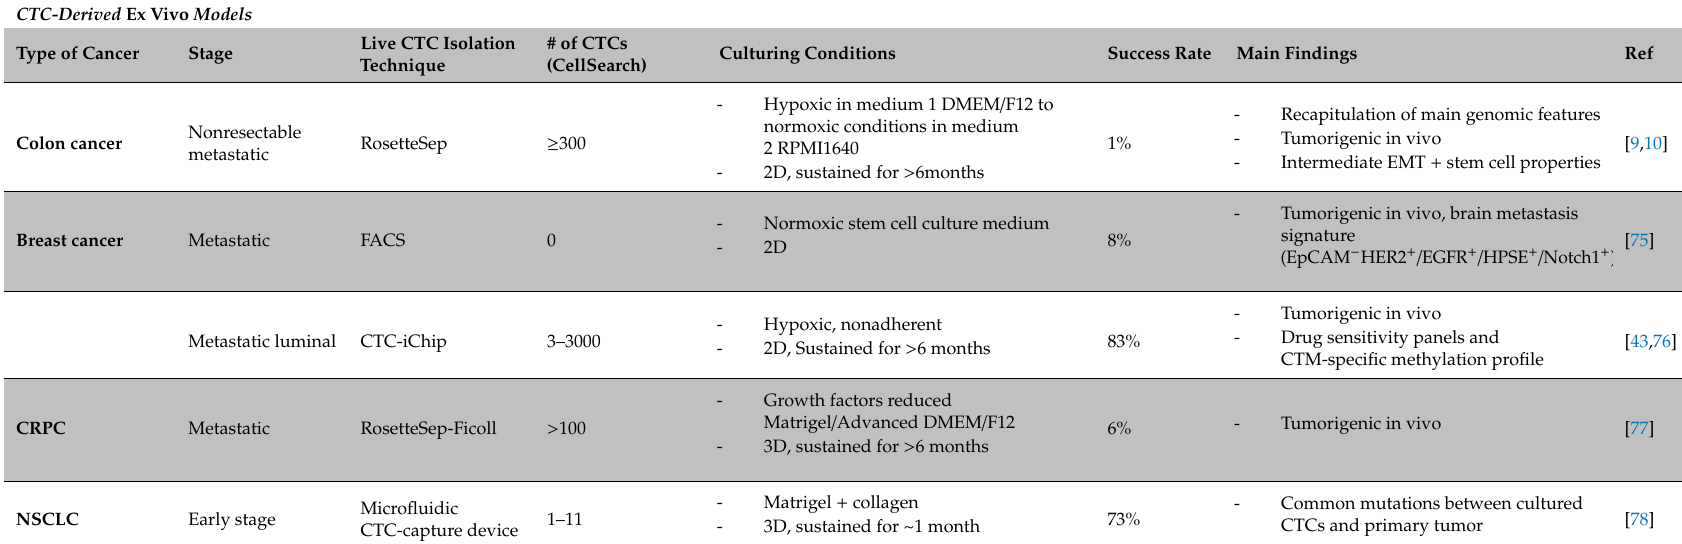
Table 3. Overview of ex vivo CTC-derived models established to